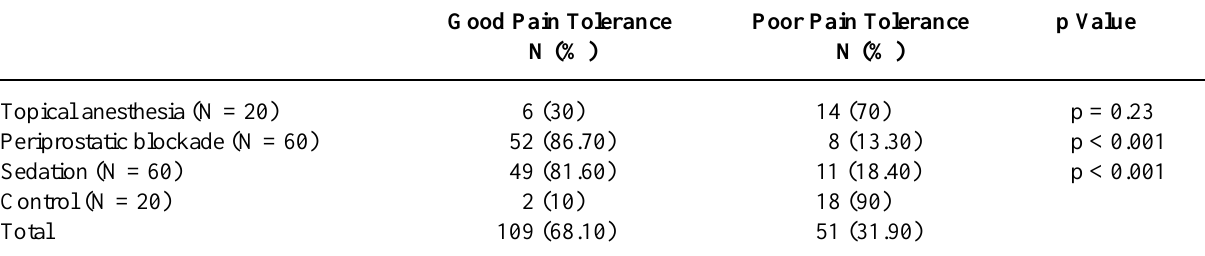
Table 2 – Comparison of pain tolerance between the control and the anesthesia groups studied.